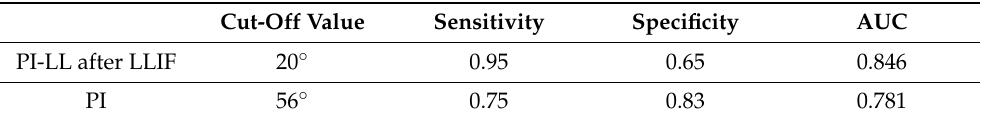
Table 6. ROC curve